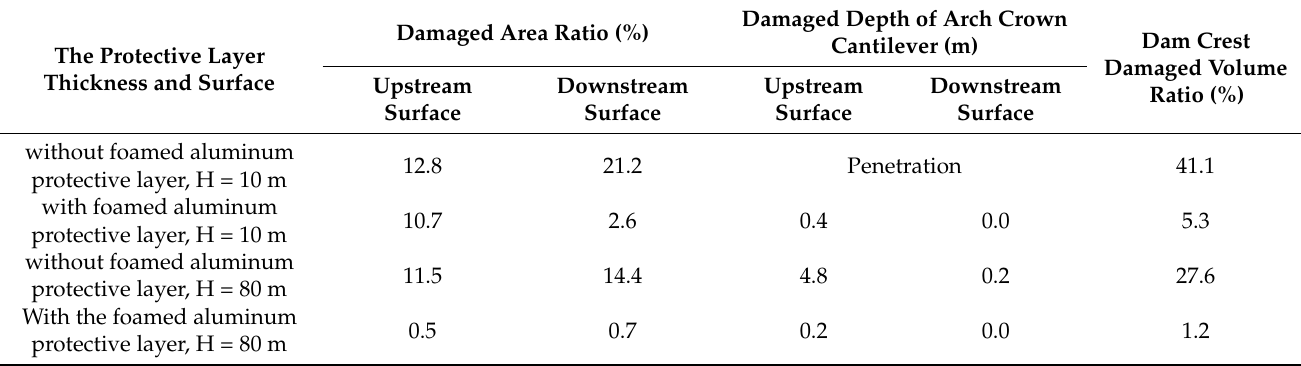
Table 7. Dam body damage with and without the foamed aluminum protective layer.